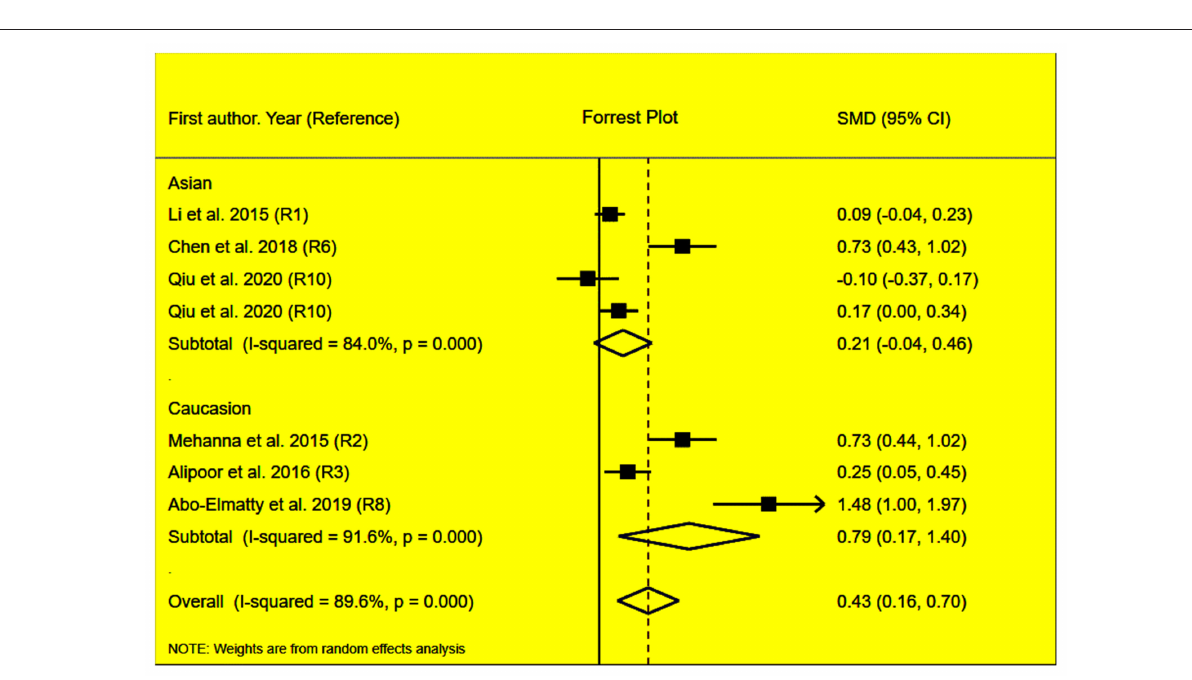
FIGURE 3 | Forest plot of the meta-analysis between miRNA-146a rs2910164 polymorphism and plasma TC levels.